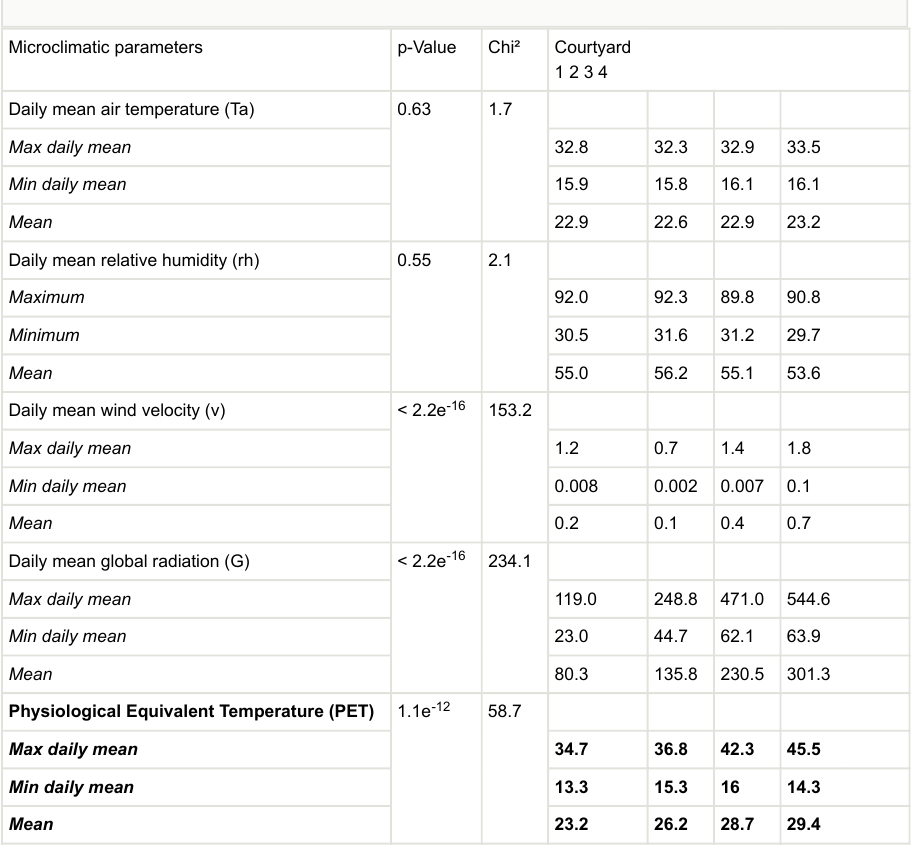
Table 5. Differences of microclimatic parameters and PET between courtyards, based on daily means and Kruskal-Wallis-Test